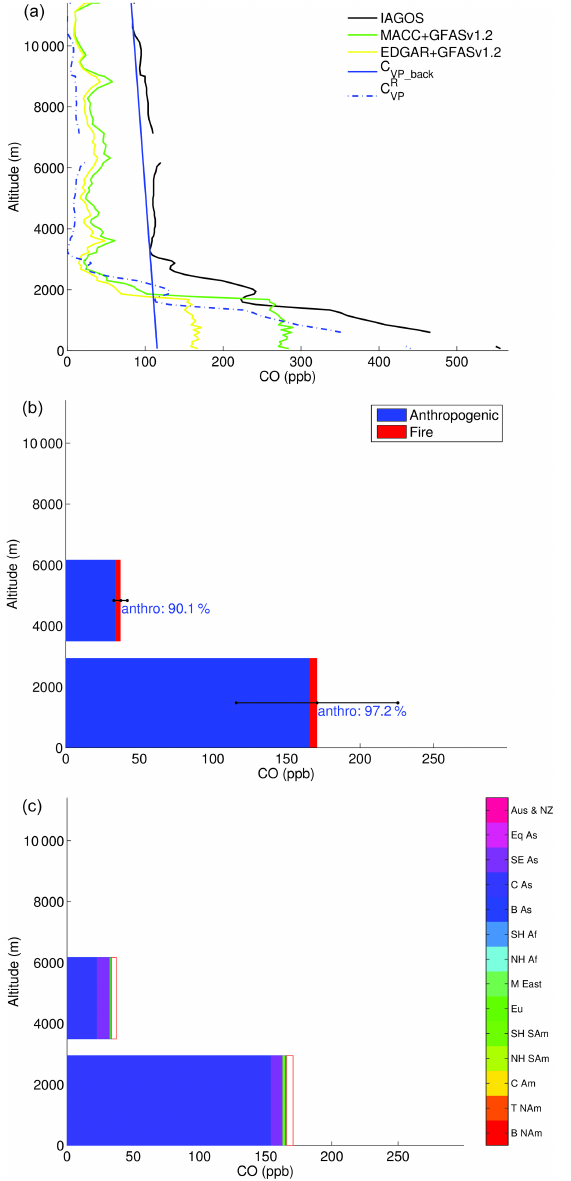
Figure 6. (a) Carbon monoxide zonal profile during the 10 March 2002 MOZAIC–IAGOS flight from Frankfurt to Denver. The black line indicates the observed CO while the blue line indicates CO seasonal background in the UT deduced from the IAGOS data set. Light green and yellow lines indicate the simulated contributions using, respectively, MACCity and EDGARv4.2 for anthropogenic emissions and GFAS v1.0 for biomass burning emissions. Dark green represents potential vorticity (PVU) from ECMWF analy- ses. Simulated CO is separated into (b) source contribution (anthro- pogenic in blue, fires in red, standard deviation in black) and (c) regional anthropogenic origins (14 regions defined for global emis- sion inventory, http://www.globalfiredata.org/data.html, see Fig. S1; unshaded red square is for fire contribution), using MACCity and GFAS